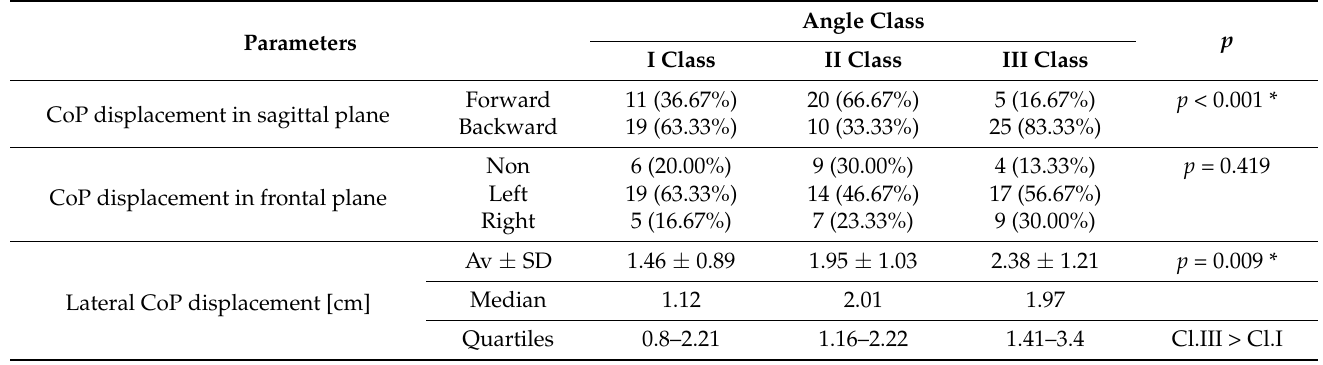
Table 3. The Angle Class and CoP displacement relative to the centre of the support polygon.